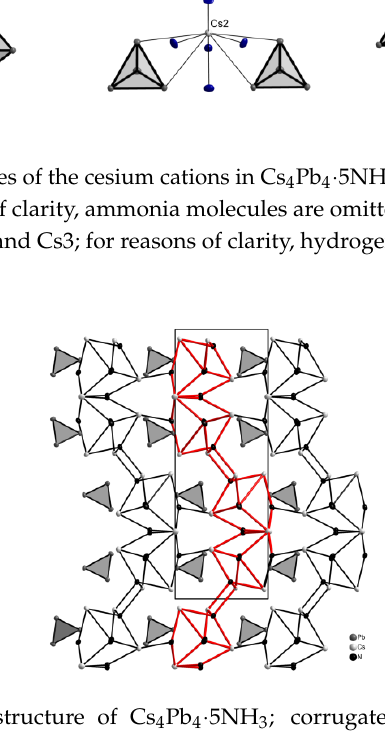
Figure 4. Section of the structure of Cs 4 Pb 4 · 5NH 3 ; corrugated Cs + -NH 3 strands along the crystallographic b-axis; the chains are emphasized by bold lines; [Pb 4 ] 4- cages are located along the strands; hydrogen atoms are omitted for clarity; probability factor: